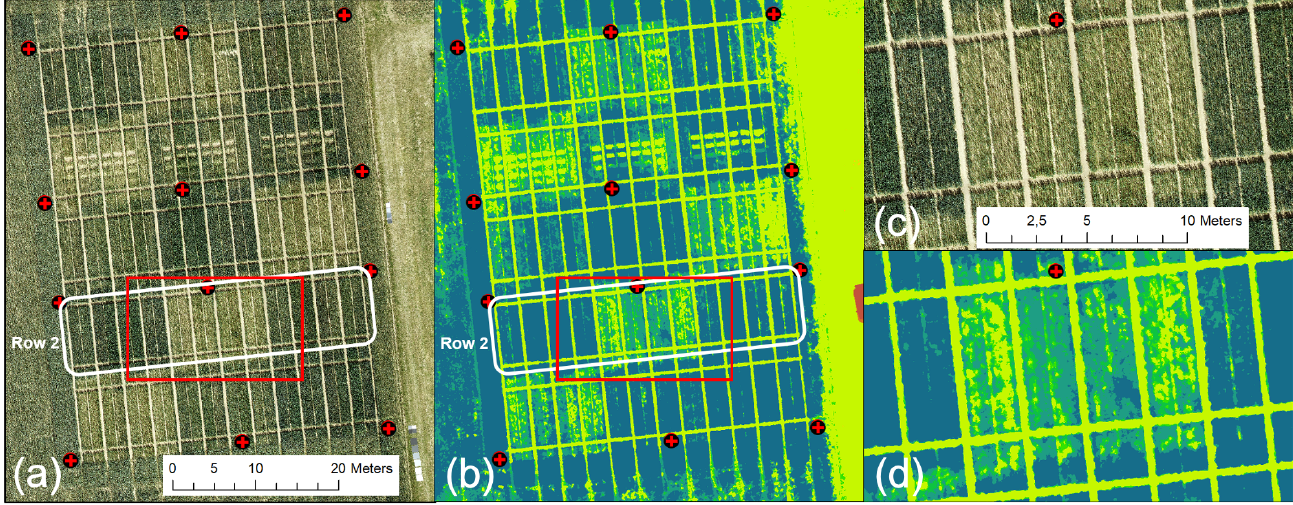
Figure 11. UAV-derived CH data for 2 June (CH legend from Figure 4 applies): ( a ) DOP, ( b ) derived CH map, ( c ) enlarged area of DOP (red rectangle in ( a ), ( d ) enlarged area of CH map (red rectangle in ( b ).